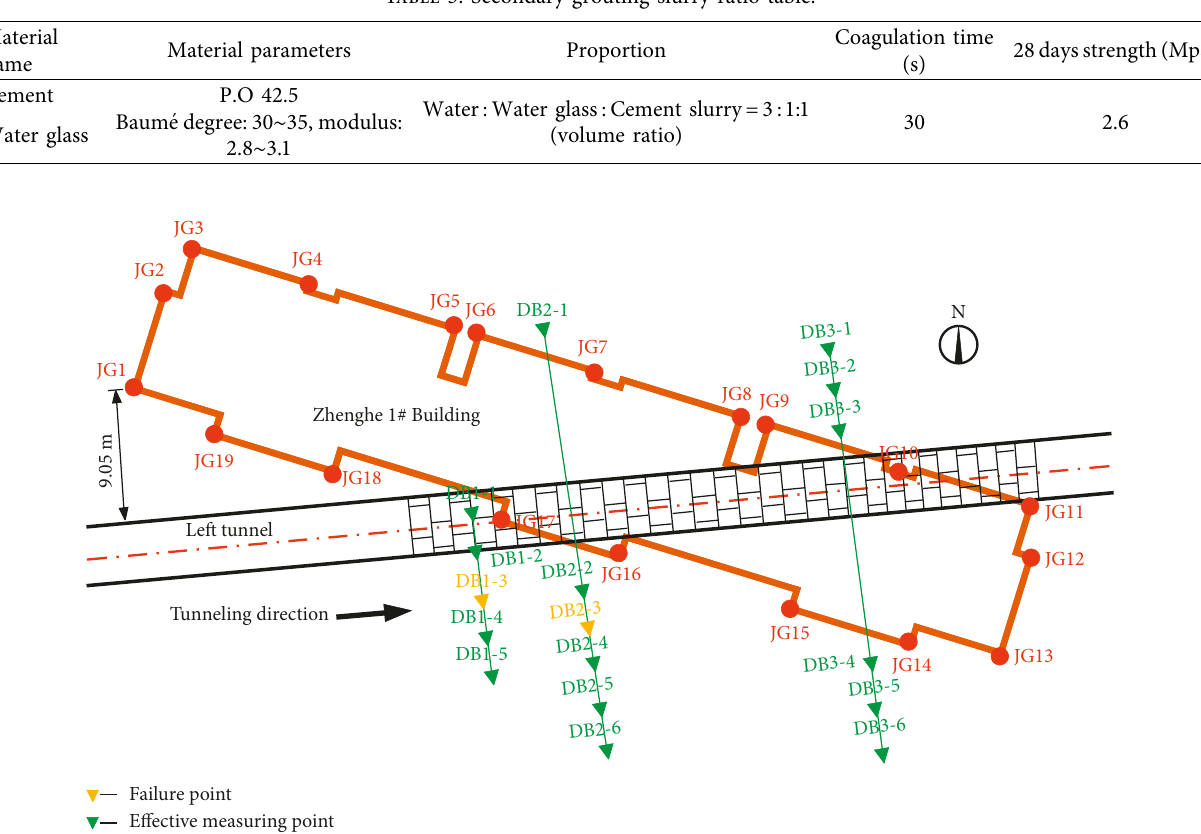
Figure 5: The relative position between building and tunnel and the plan of monitoring